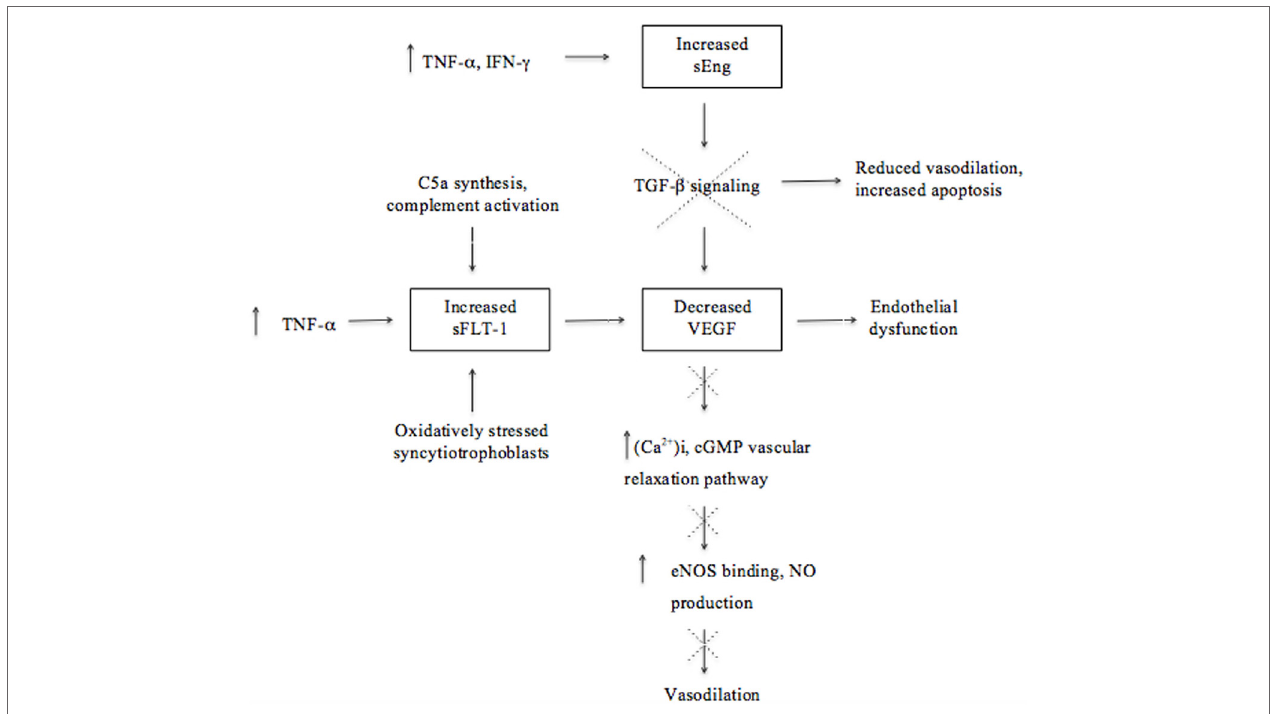
FiGURe 1 | Molecular mechanisms involved in the upregulation and downregulation of antiangiogenic and angiogenic factors ultimately leading to endothelial dysfunction and reduced vasodilation in the pathogenesis of preeclampsia. Although there is a lack of proof that soluble fms-like tyrosine kinase (sFlt-1) is associated with excessive systemic inflammation, this illustration emphasizes the effect of the immune system on angiogenesis and that dysregulation thereof could contribute to the pathogenesis of